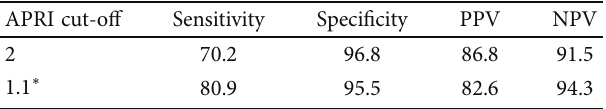
Table 5: Performance of APRI score in the diagnosis of